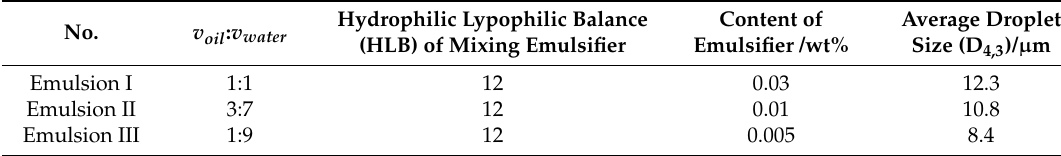
Table 2. Oil-to-water ratios and average droplet size of three emulsion s.